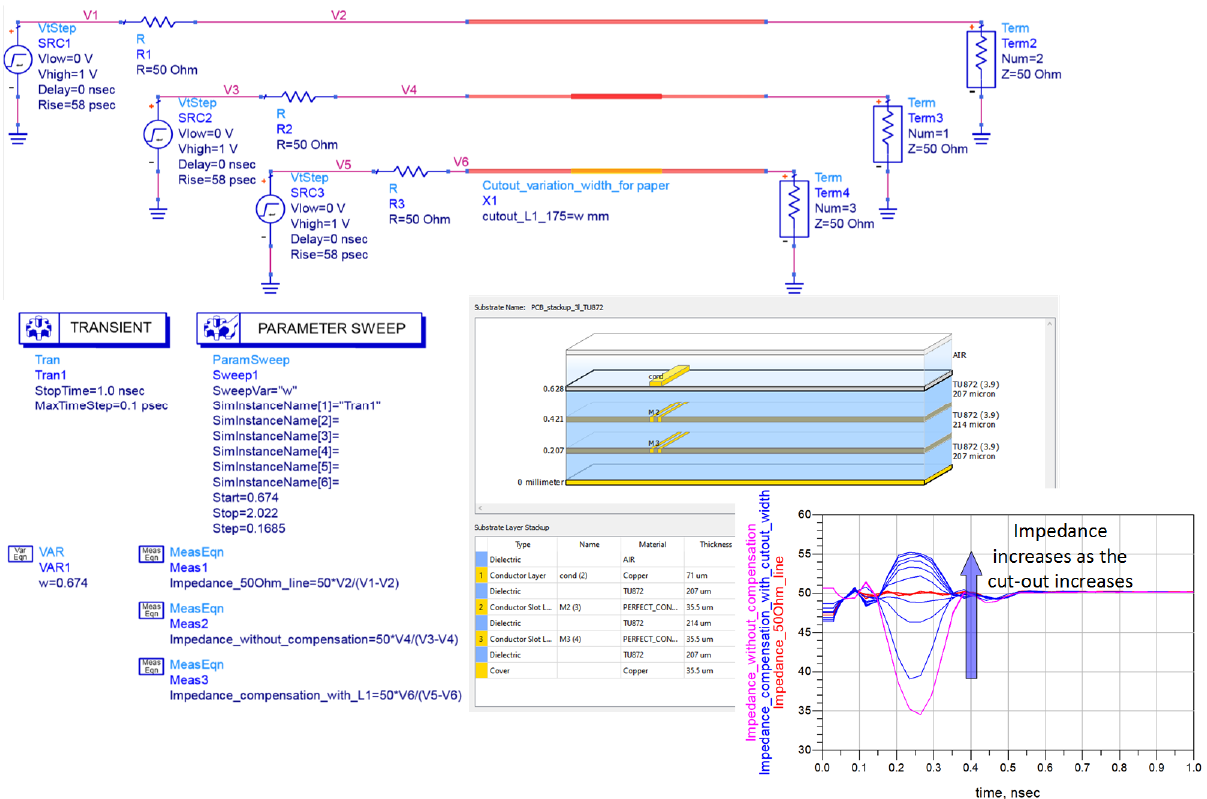
Figure 4. Keysight Agilent ADS test-bench schematic, stack-up and TDR response for a track-to- discontinuity ratio 1:1.75.